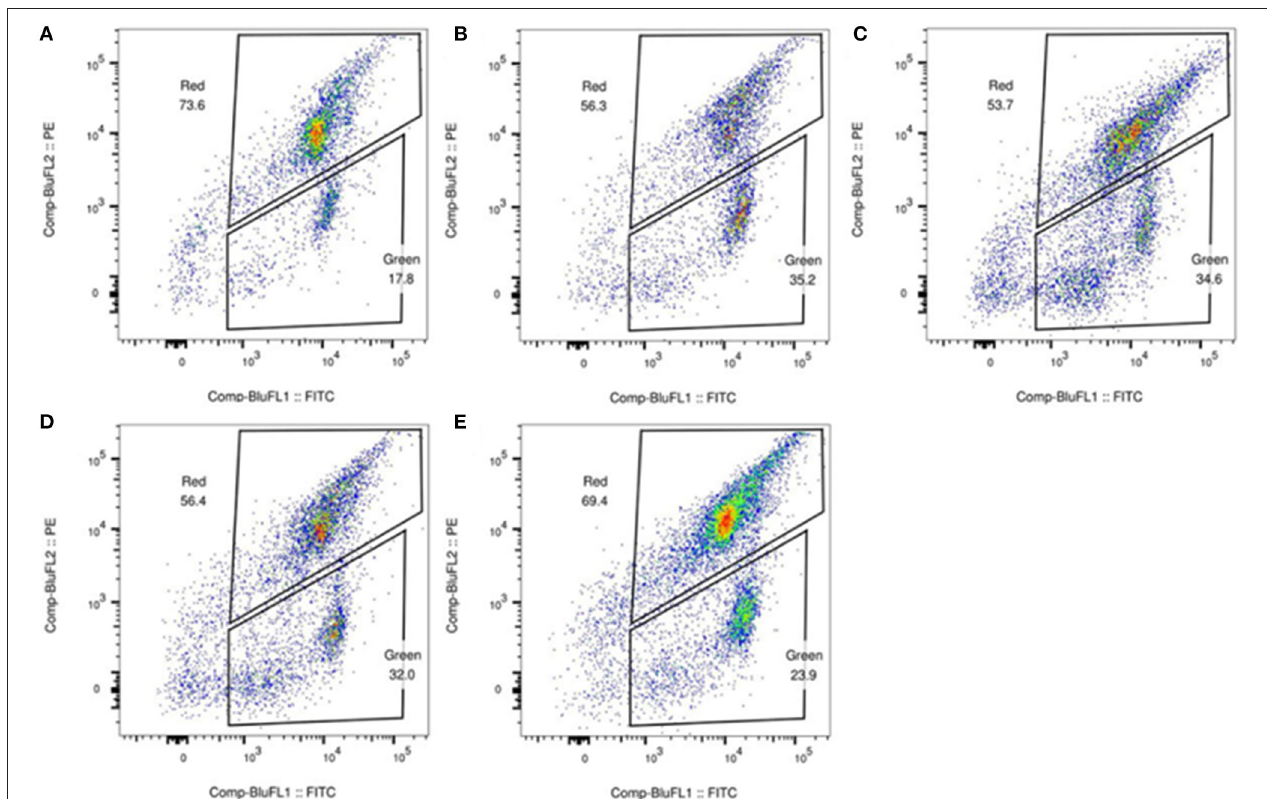
FIGURE 2 | Detection of mitochondrial membrane potential in white blood cell. The flow cytometry analysis of the fresh peripheral blood white blood cell in the patients (B) (the father), (C) (case 3), (D) (the health 5-year-old child), (E) (the mother), and healthy control (A) stained with JC-1. The result revealed that the ratio of red to green fluorescence of (B–E) is lower than that of healthy group (A) , suggesting that the mitochondrial membrane potential of (B–E) is likely impaired.